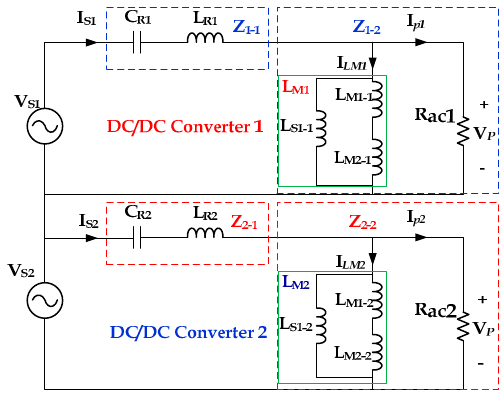
Figure 7. The proposed DC/DC converter using a coupled shunt inductor and multiple input transformers.